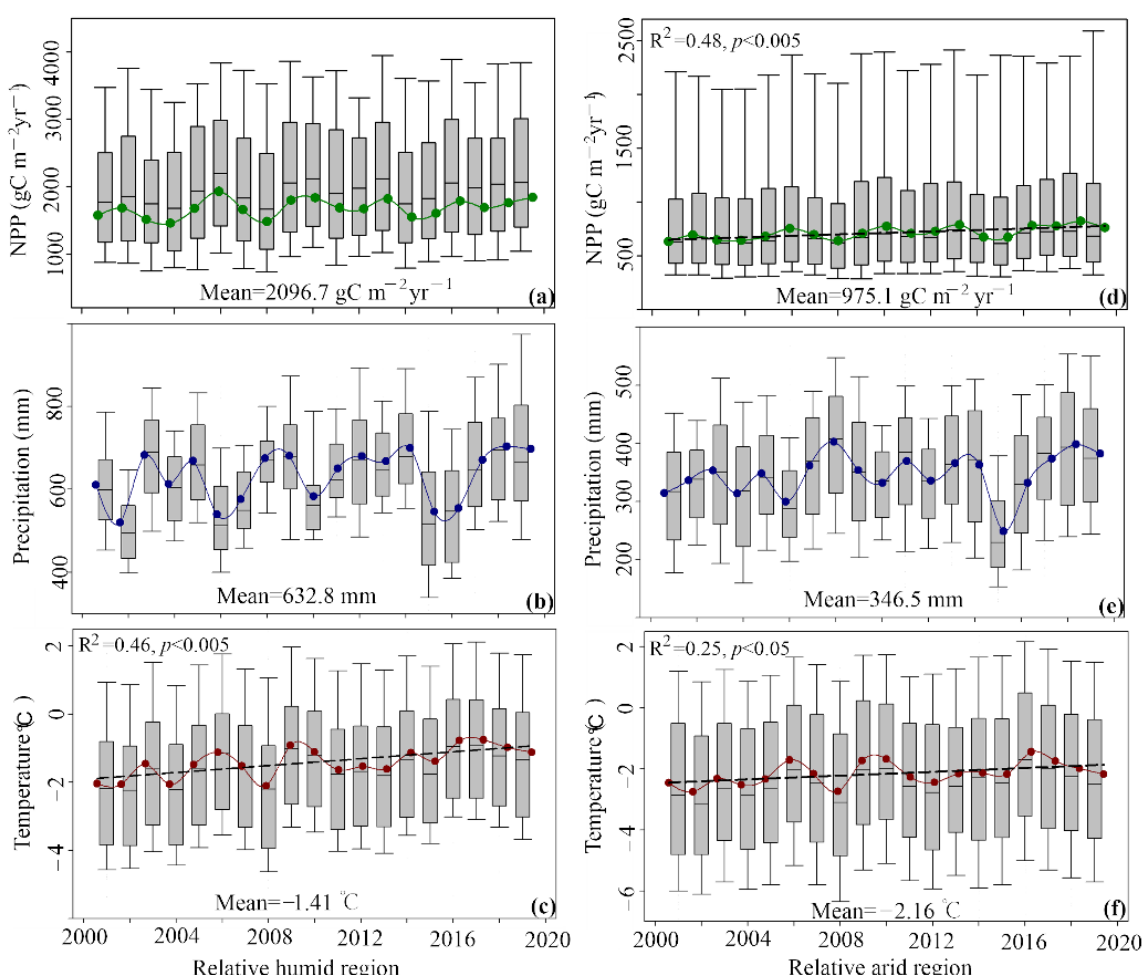
Figure 4. The dynamics of the NPP ( a ), precipitation ( b ), and temperature ( c ) in relatively humid regions and the dynamics of the NPP ( d ), precipitation ( e ), and temperature ( f ) in relatively arid regions from 2001 to 2019.